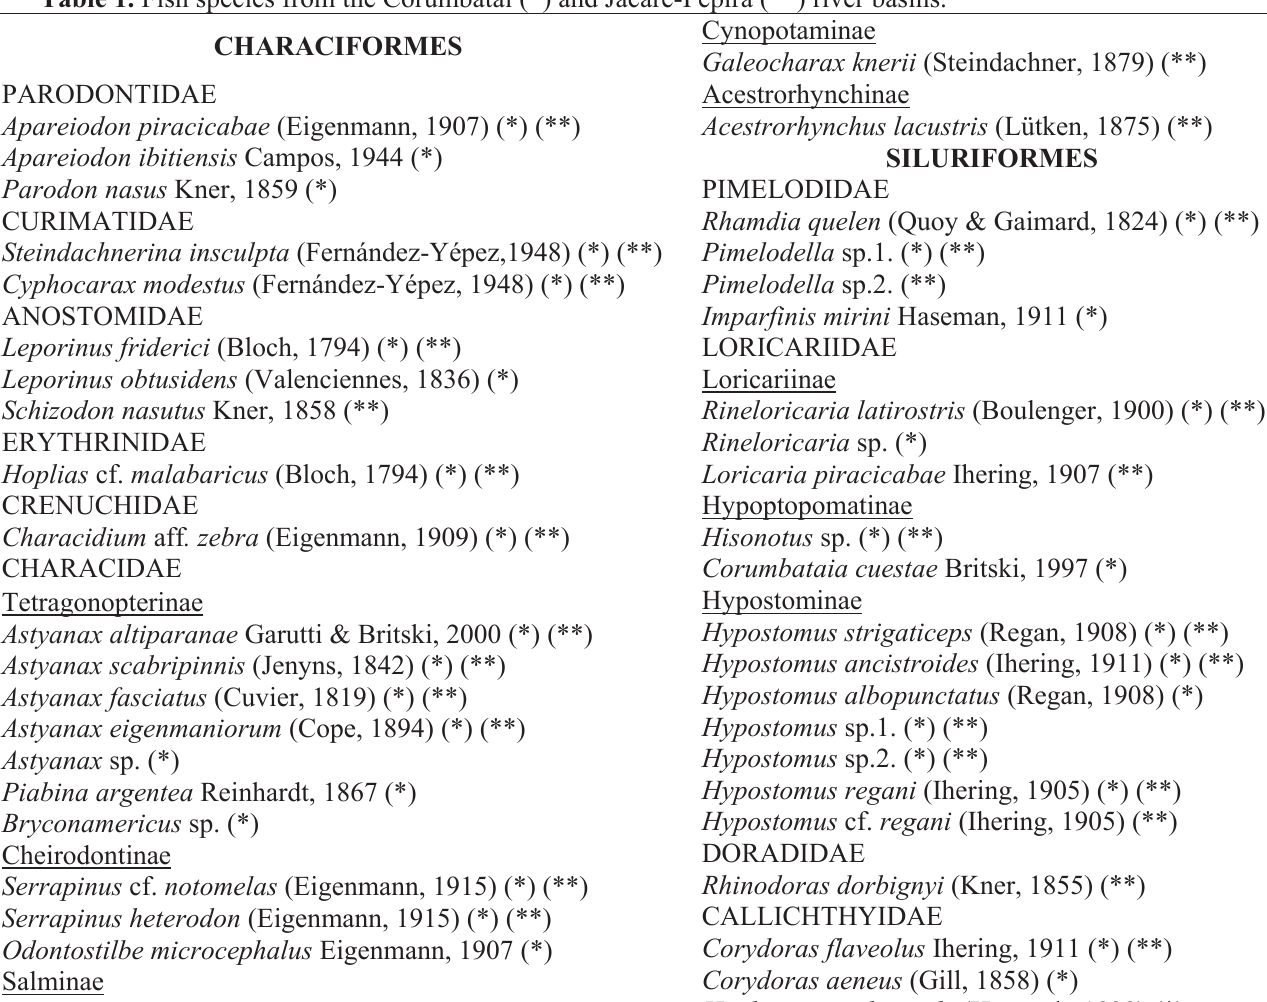
Table 1. Fish species from the Corumbataí (*) and Jacaré-Pepira (**) river basins. CHARACIFORMES